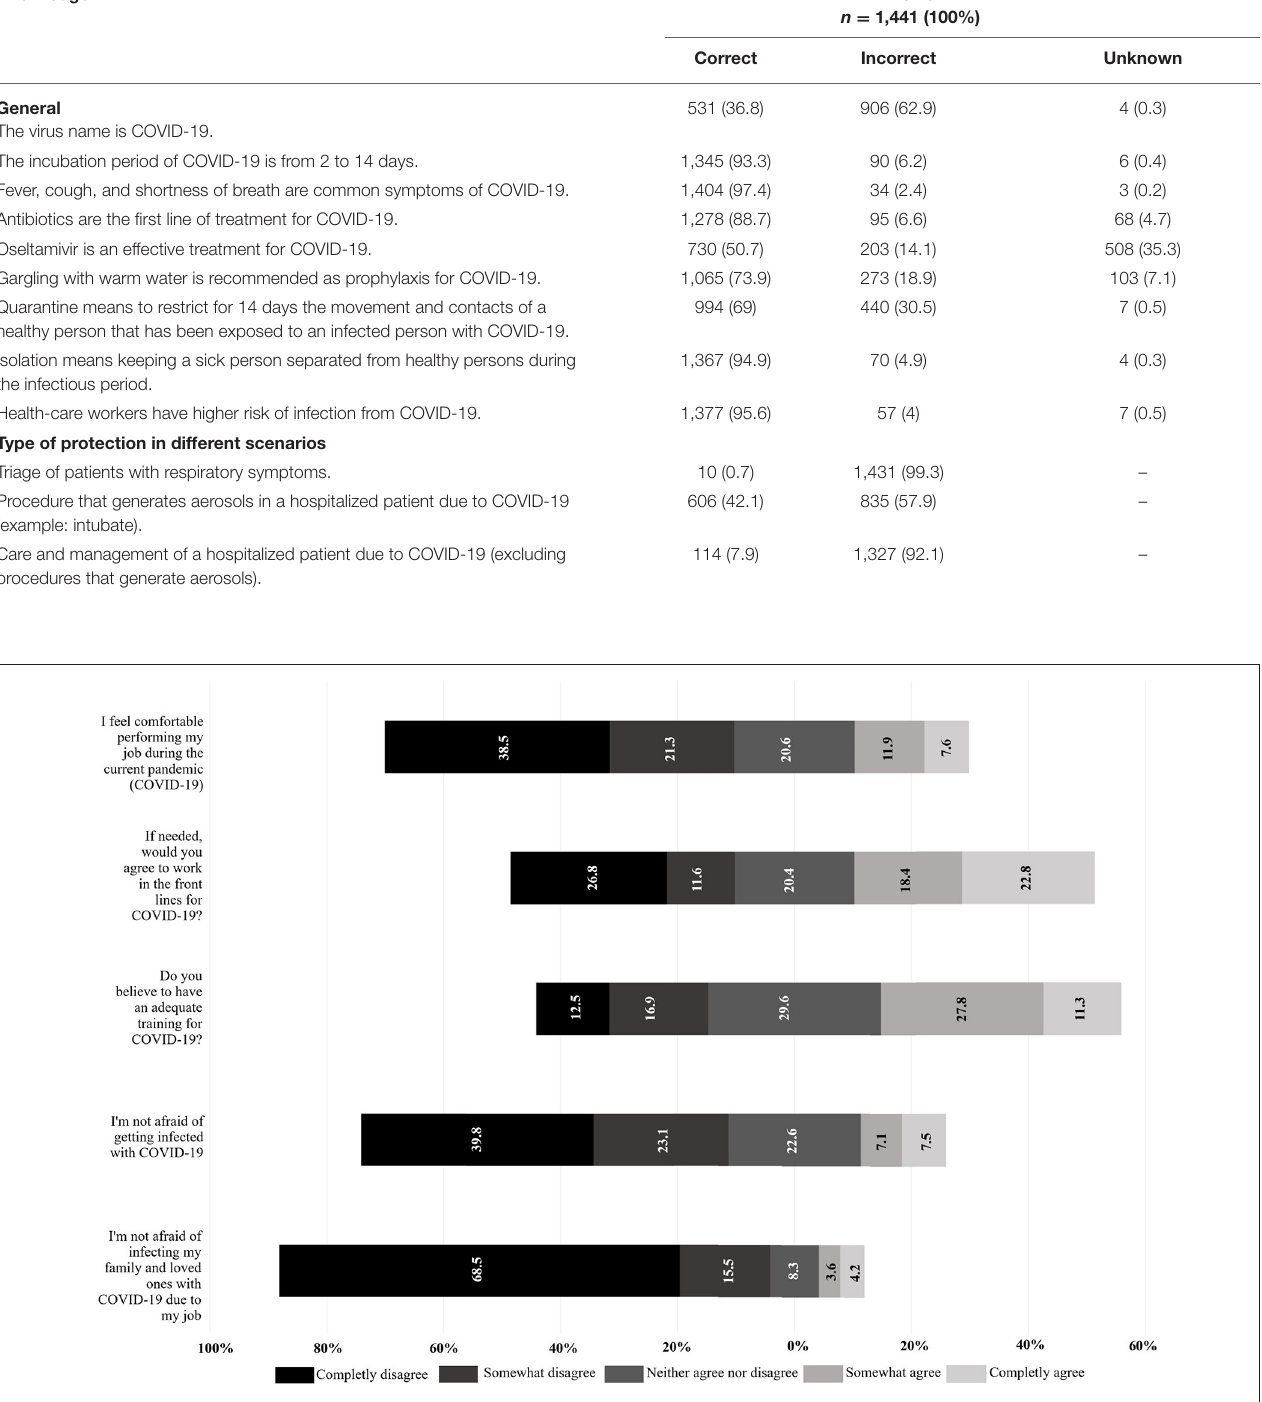
FIGURE 2 | Attitudes regarding COVID-19 in healthcare workers. Piled Bars showing proportion of patients according to their choice for each item in the attitudes dimension. Better attitudes tend to the right; worse attitudes tend to the left. Indifferent attitudes (gray bars) are placed in the middle. Figure was performed using Microsoft ® Excel ® version 2013 (Microsoft, Redmond, WA, United